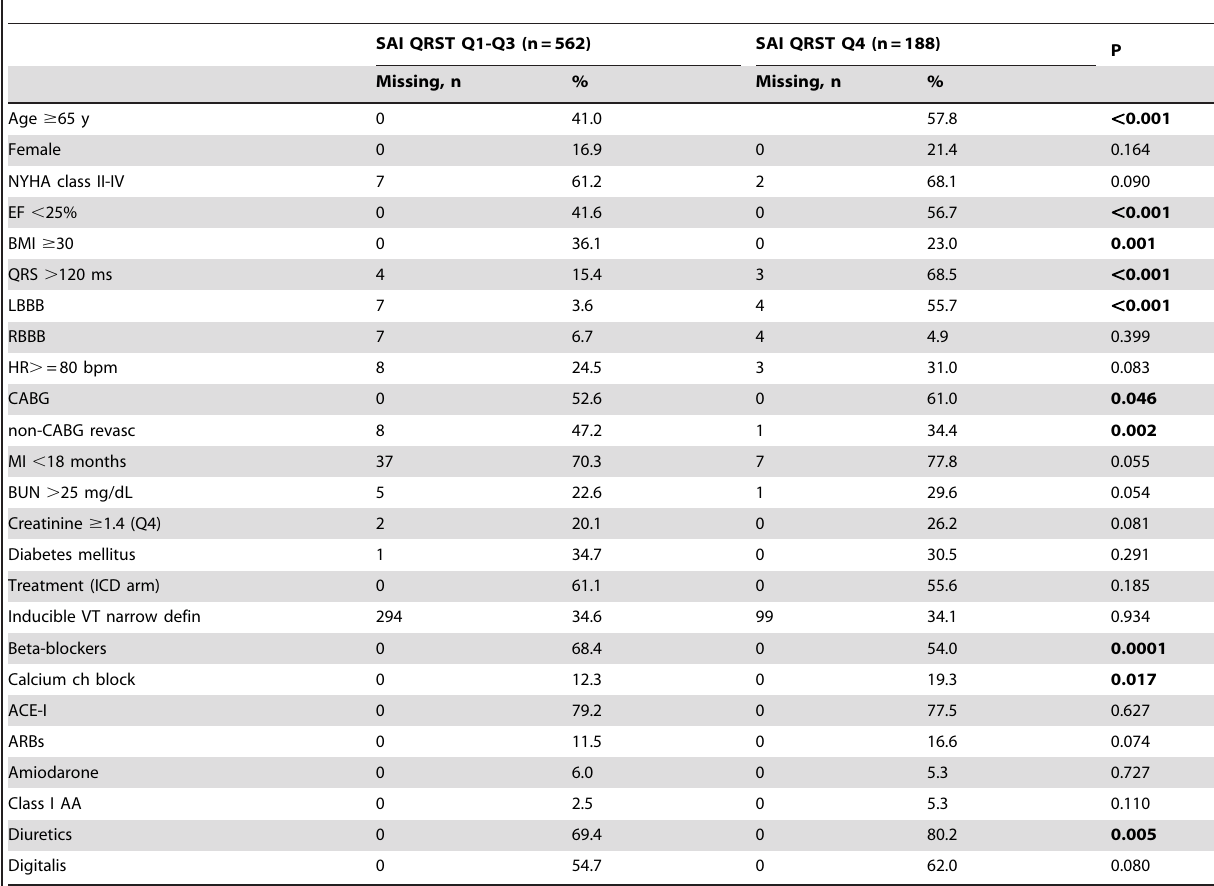
Table 1. Baseline clinical characteristics of patients with SAI QRST, dichotomized at the 75 th percentile ( . 334